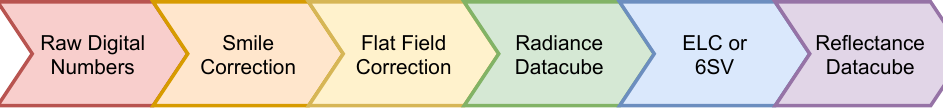
Figure 10. Flowchart of steps to obtain surface reflectance from raw digital numbers